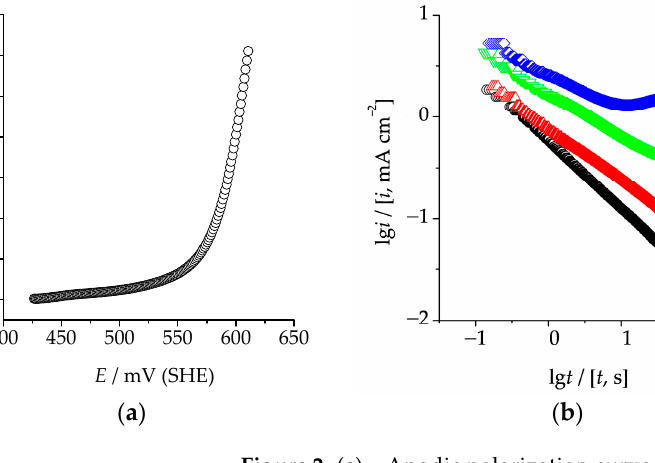
Figure 2. ( a )—Anodic polarization curve, ( b )—anodic chronoamperograms in double logarithmic coordinates, ( c )—anodic chronoamperograms in the Cottrell coordinates obtained on the Cu 85 Pd 15 alloy in 5 mM CuSO 4 + 0.5 mM H 2 SO 4 + 0.05 M Na 2 SO 4 at the potential scan rate of 1 mV/s.